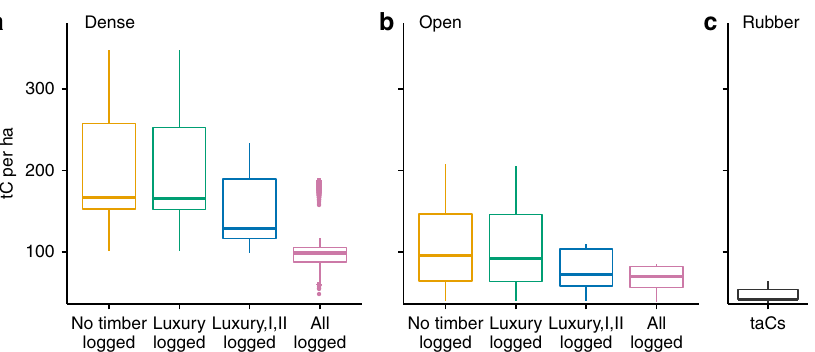
Fig. 2 Effects of selective logging on dense and open forest carbon stocks. Carbon stock (tC per ha) of a dense and b open forest in initial state ( “ No timber logged ” ) and under scenarios of selective or complete logging (following Fig. 1), and c time-averaged carbon stocks (taCs) of rubber plantations in Southeast Asia 3 . Central bar shows median, box shows upper and lower quartiles, whiskers extend to 1.5× the inter-quartile range, and outliers are